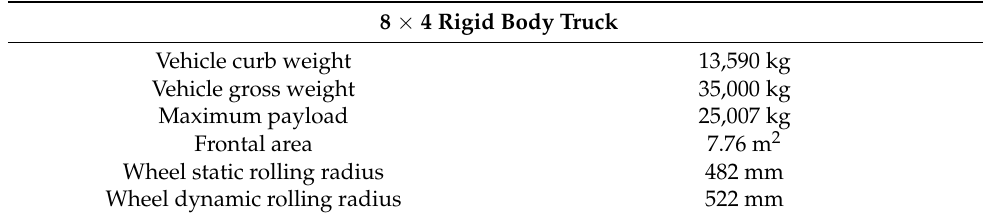
Figure 2. Test vehicle dynamics and dimensions. Table 1. Specification of the test vehicle.